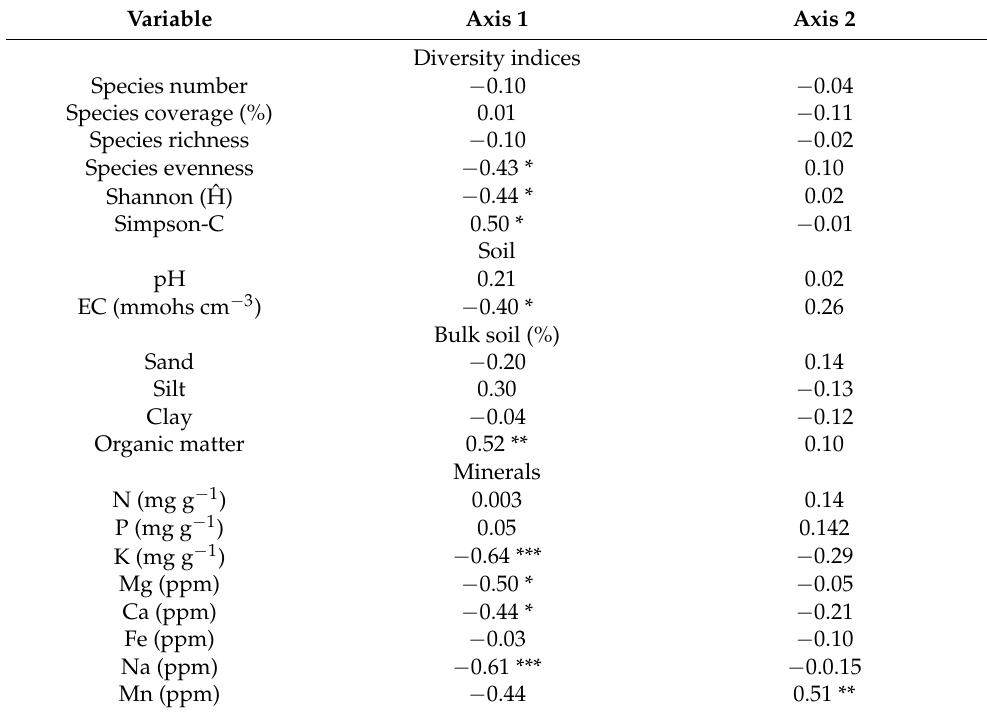
Figure 4. A biplot resulted from canonical correspondence analysis of the 58 sampling stands ordination according to species diversity indices and soil variables. Table 2. Biplot scores of different diversity indices and soil variables with the ordination